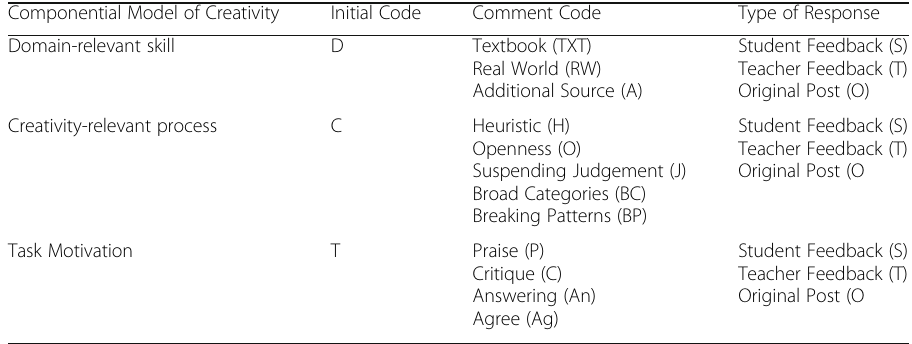
Componential Model of